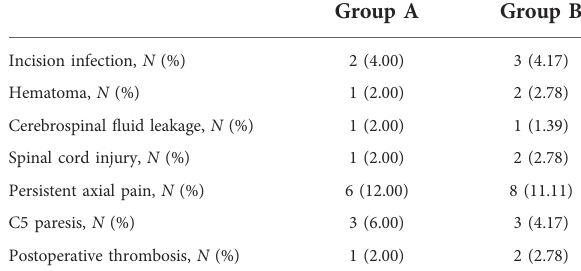
TABLE 4 Postoperative complication between Group A and Group B. Group A